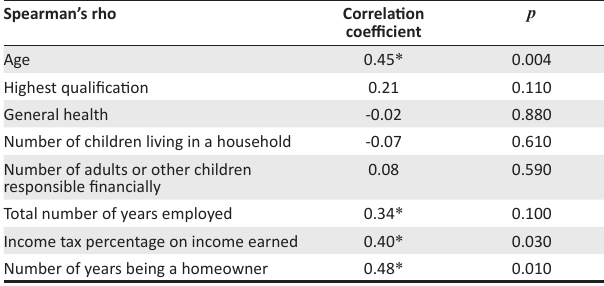
TABLE 10: Correlations with personal finance well-being